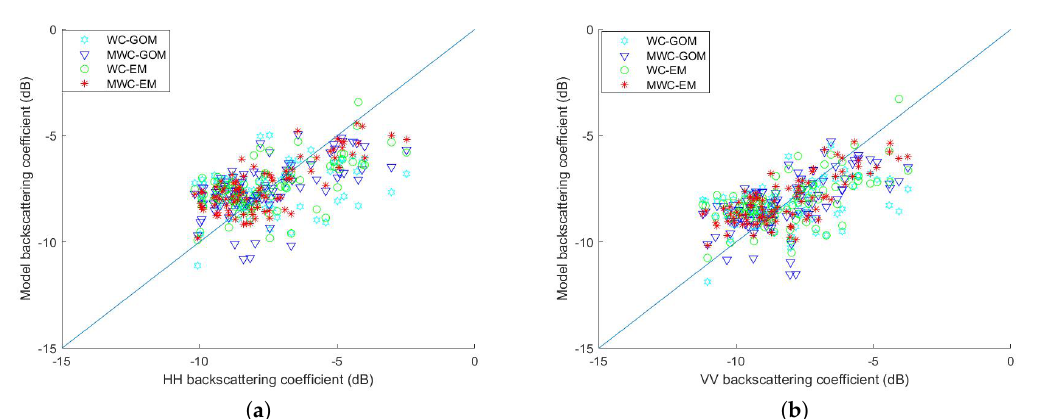
Figure 6. Comparison of actual SAR backscattering coefficients data with simulations using different models. ( a ) HH polarization; ( b ) VV